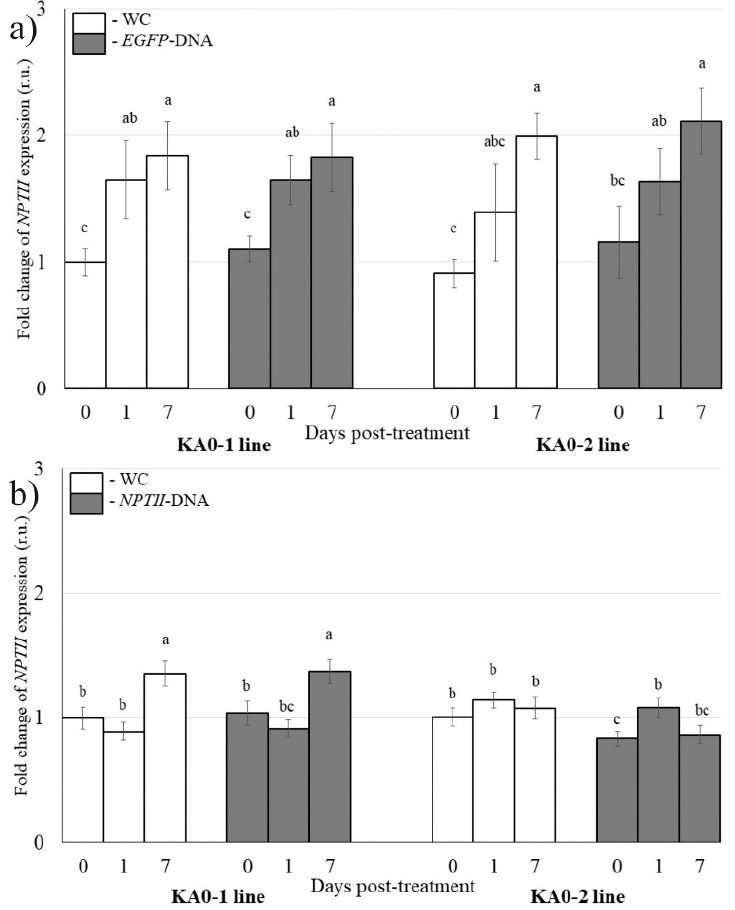
Figure 3. The analysis of NPTII mRNA levels in Arabidopsis thaliana in response to external applica- tion of synthetic EGFP -DNA ( a ) and NPTII -DNA ( b ) mimicking dsRNAs. The NPTII mRNAs were measured 1 day and 7 days post-treatment. WC— A. thaliana treated with sterile water (100 µL per plant); EGFP -DNA and NPTII -DNA— A. thaliana treated with synthetic DNAs. The synthesized EGFP - and NPTII -DNAs were diluted in water to a concentration of 0.35 µg/µL (100 µL per plant). KA0-1 and KA0-2—transgenic Arabidopsis lines bearing the NPTII transgene under the control of the doubled CaMV 35S promoter. qRT-PCR data are presented as mean ± SE (three independent experiments). Means on each figure followed by the same letter were not different using one-way analysis of variance (ANOVA), followed by the Tukey HSD multiple comparison test.